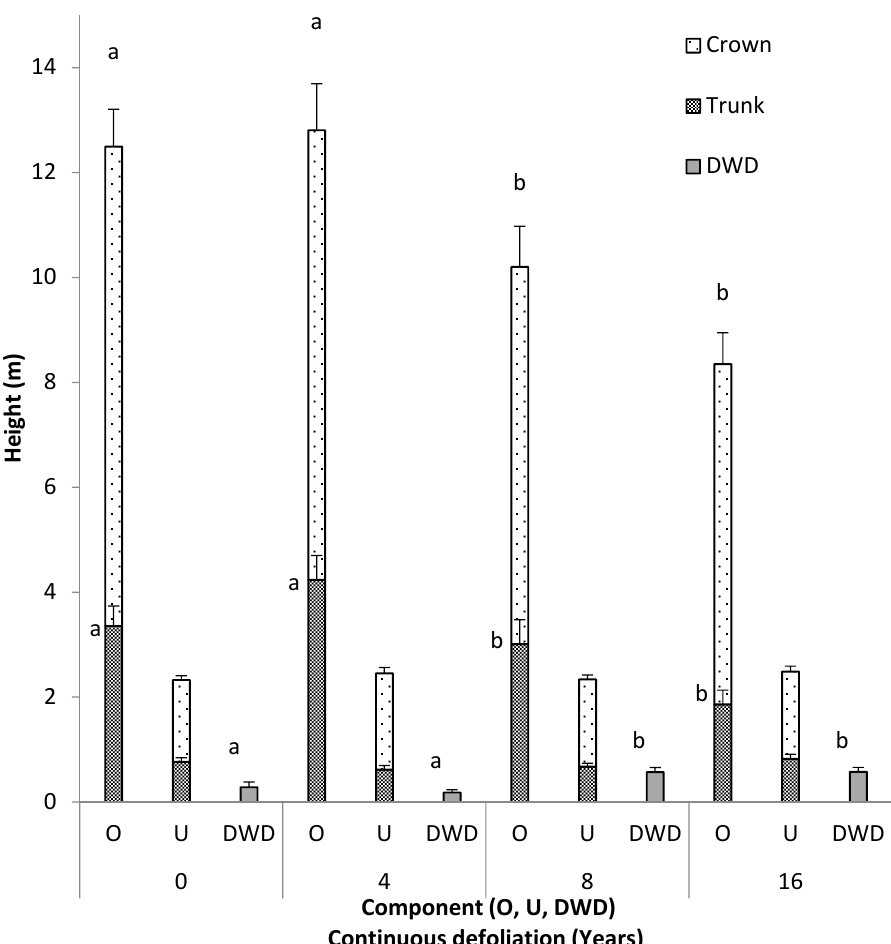
Figure 5. Vertical forest structure showing mean top height (top of crown component; n = 60), crown base height (bottom of crown component and top of trunk component; n = 60), downed woody debris height (DWDH; n = 25) by years of continuous spruce budworm defoliation from 1993–2008 in boreal mixedwood forest near Warren, Ontario for host overstory (O) trees, host understory (U) trees and downed woody debris (DWD). Among treatments, means with the same letters were not significantly different (Wilcoxon rank sum test; p < 0.05). Error bars show standard error of the mean. Note: Eight to sixteen years on x -axis is eight years. Forests 2018 , 9 , x FOR PEER REVIEW